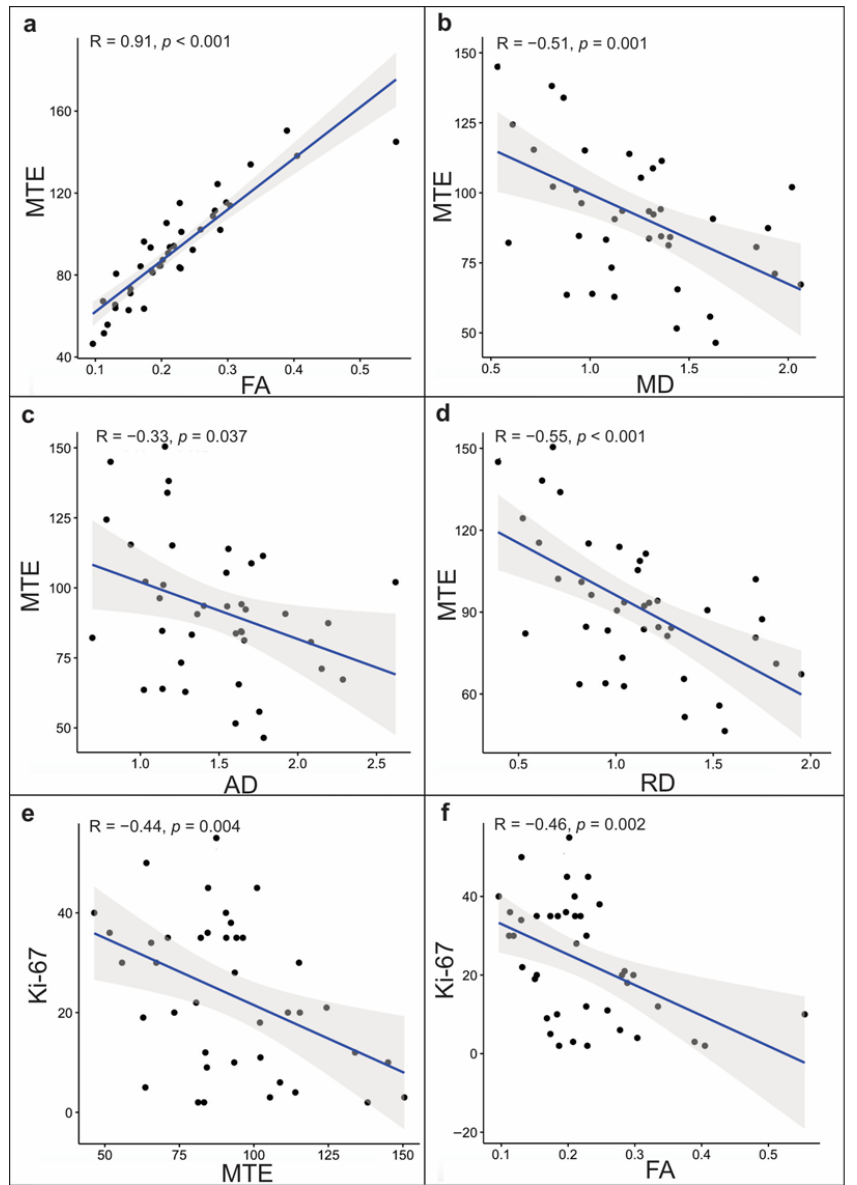
Figure 4. Scatterplots of a correlation analysis of the whole tumor volume for the mean tissue elasticity (MTE) and ( a ) fractional anisotropy, ( b ) mean diffusivity, ( c ) axial diffusivity, and ( d ) radial diffusivity. Significant correlations were also found between Ki-67, ( e ) MTE, and ( f ) fractional anisotropy. Table 3. Univariate analysis of Ki-67 groups.